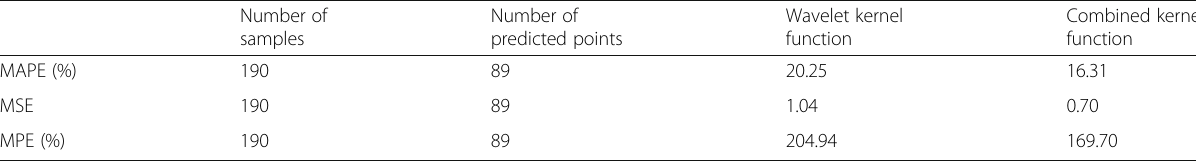
Table 2 A comparison of the prediction error between the wavelet kernel function and combined kernel function for 279 samples Number of Number of samples predicted points